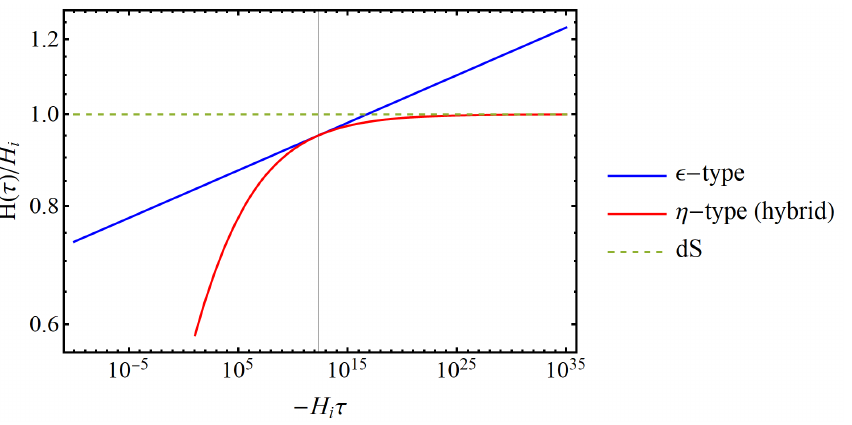
Figure 17 . The Hubble parameter for two spacetimes are chosen to be tangent to each other at the time τ 0 , which is indicated by the vertical black